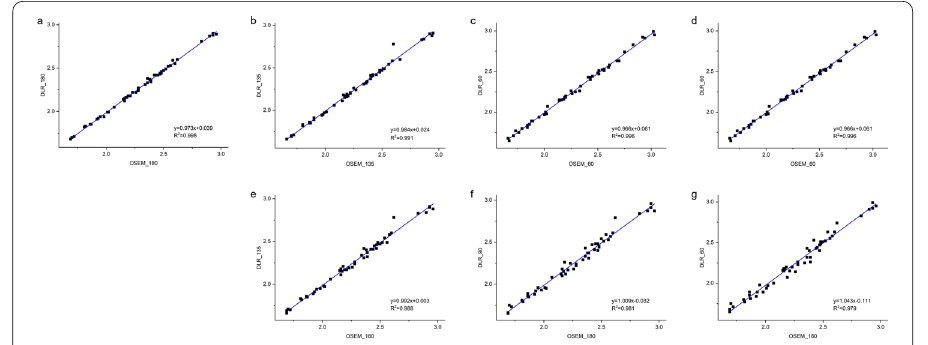
Fig. 7 Linear regression of liver SUVmax between GS and DLR groups. Subfigures a-d show the results between GS and DLR images with the same acquisition time. Subfigures a , e , f and g indicate a strong relationship between DLR groups and the reference GS_180 group. The above results demonstrate the good agreement of SUV between the groups. SUV, standardized uptake